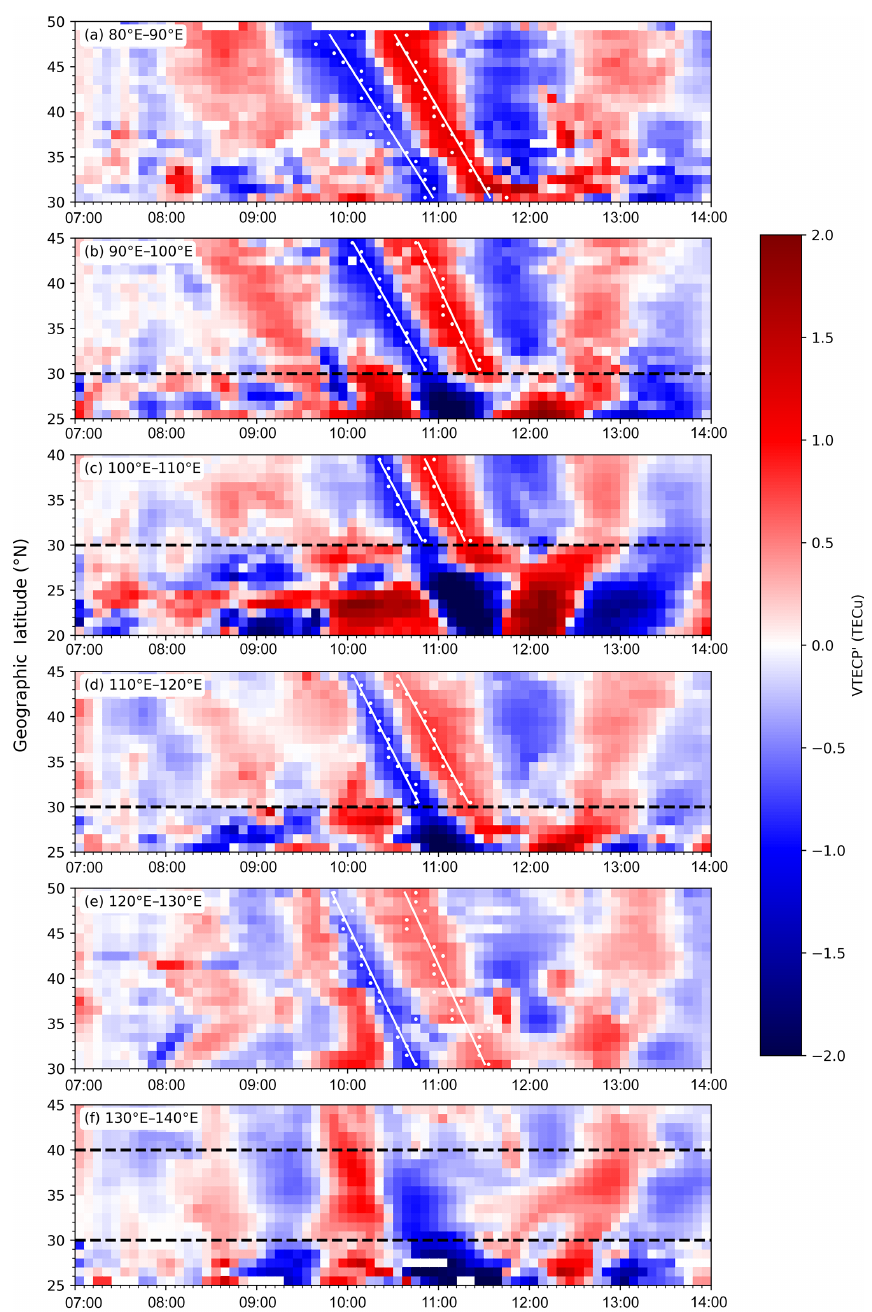
Figure 8. TLPs of VTECP (cid:48) for different longitudinal bands between 07:00 and 14:00UT. White dots give the data points for linear fitting, and the fitting results are marked with white lines; 30 ◦ N in (b–d) and (f) is marked with black dashed lines, which indicate the boundary of EIA, and 40 ◦ N is marked in (f)